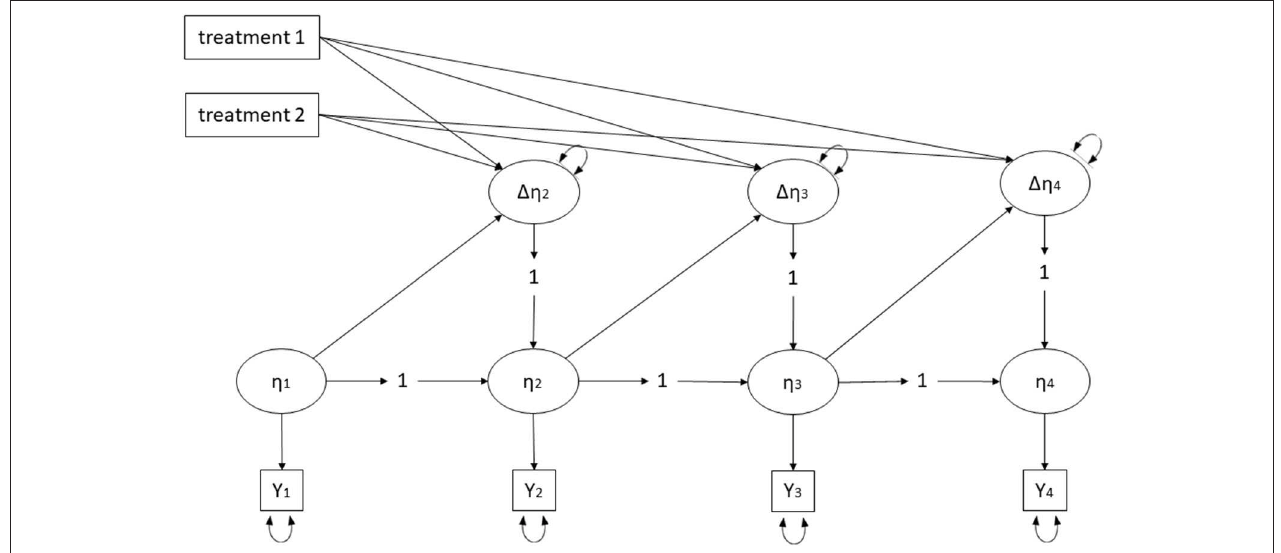
FIGURE 1 | Path diagram for a latent change score model. For the purpose of better clarity, the covariances are not